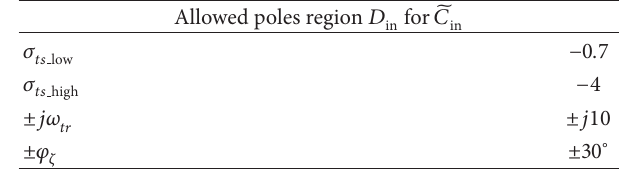
Table 4: Allowed region for optimized internal-loop poles a complex plain.